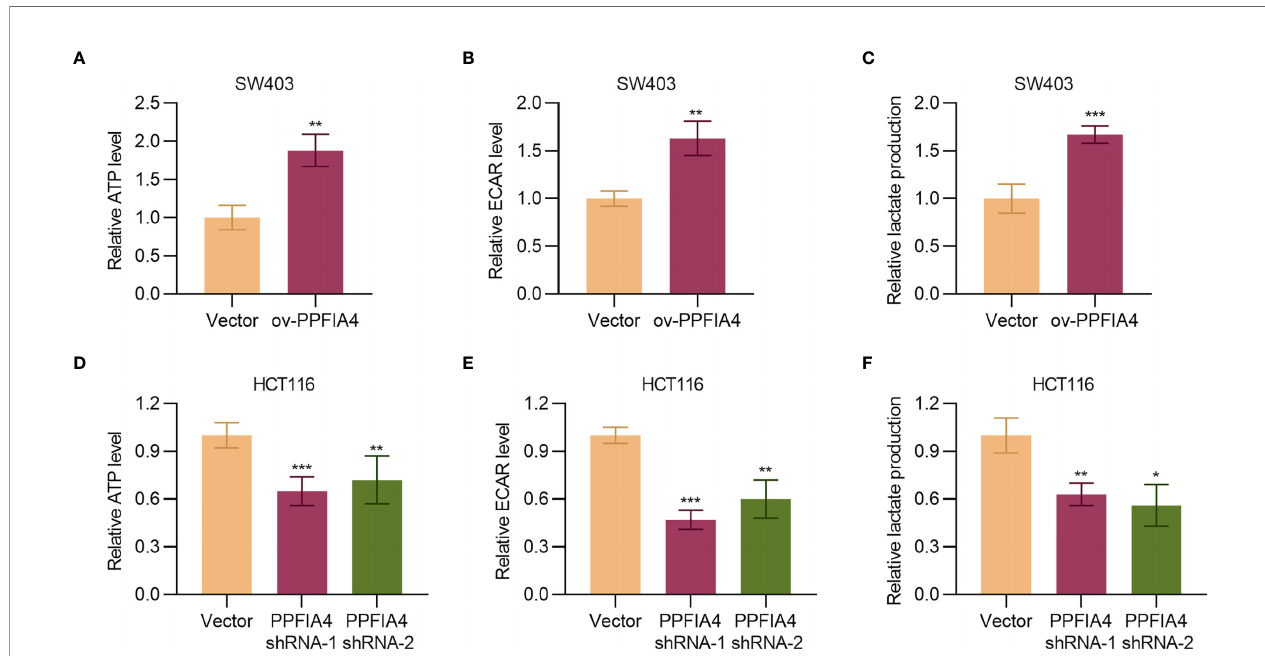
FIGURE 4 | PPFIA4 promotes glycolysis. (A) Total ATP levels were measured in SW403 cells transfected with PPFIA4 expression plasmid or vector. (B) ECAR levels were measured in SW403 cells transfected with PPFIA4 expression plasmid or vector. (C) Extracellular lactate production in SW403 cells transfected with PPFIA4 expression plasmid or vector. (D) Total ATP levels were measured in HCT116 cells transfected with PPFIA4 expression plasmid or vector. (E) ECAR levels were measured in HCT116 cells transfected with PPFIA4 expression plasmid or vector. (F) Extracellular lactate production in HCT116 cells transfected with PPFIA4 expression plasmid or vector. *p < 0.05, **p < 0.01, ***p <